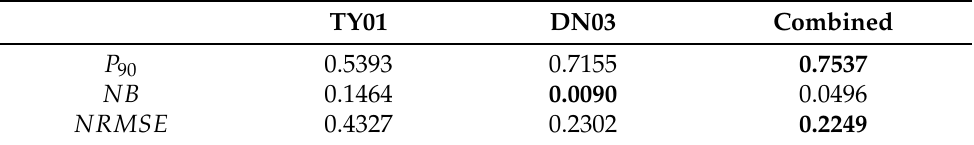
Figure 4. Measured drag coefficient vs. the value predicted by Equation (23) for eight datasets. Data points fall within the 90% confidence regions are shown in black points, and data points fall outside the 90% confidence regions are shown in grey points. Solid lines indicate the best fit between observations and predictions. Dashed lines represent the upper and lower boundaries of the 90% confidence regions. Table 7. P 90 , NB , and NRMSE predicted by TY01, DN03, and the combined scheme (Equation (23)) for the total eight